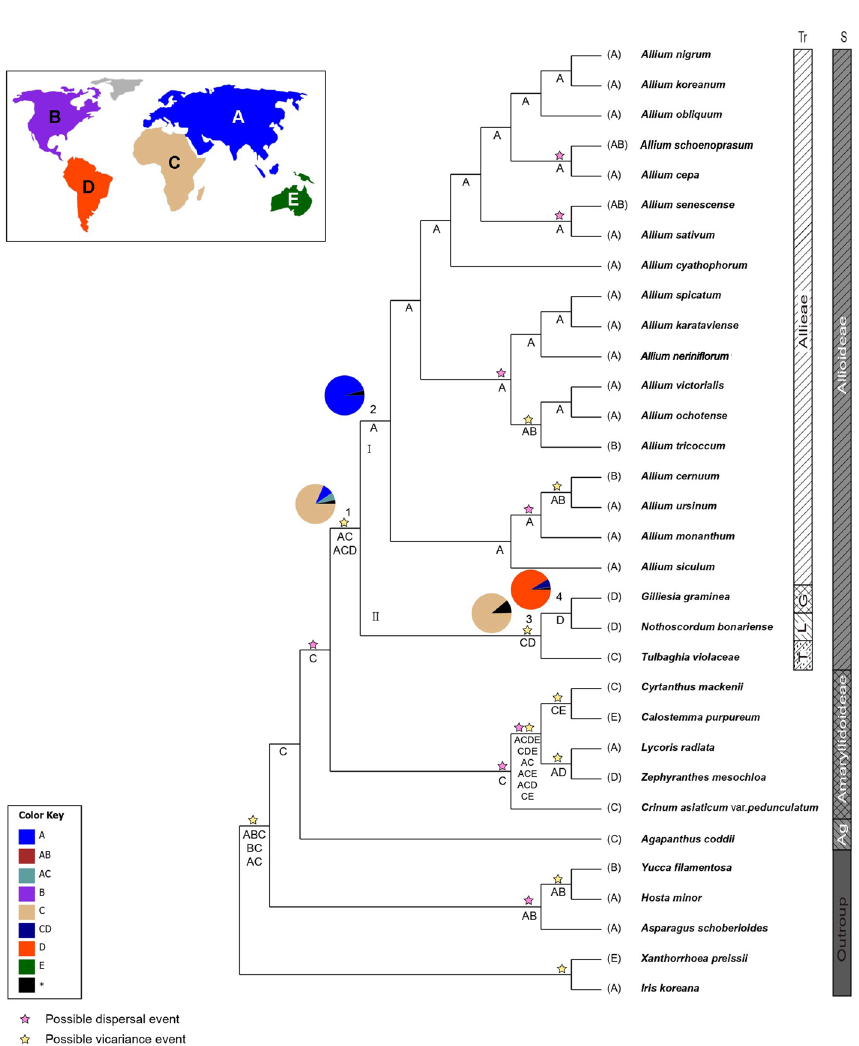
Figure 4. Summary of the Bayesian binary method (BBM) and statistical dispersal—vicariance analysis (S-DIVA) models of ancestral area reconstruction in Allioideae based on the BEAST combined-gene chronogram. The BBM ancestral area reconstructions with the highest likelihood are shown as pies for each Allioideae clade. Colour key for ancestral reconstruction at nodes of interest obtained from BBM analysis is provided in the figure. The results of S-DIVA reconstruction are indicated above the branches. The clades (I, II) and numbers (1–4) correspond to those in Fig. 3 (see Table 2 for details). Biogeographic regions used for BBM and S-DIVA analyses: A, Eurasia; B, North America; C, Africa; D, South America; and E,